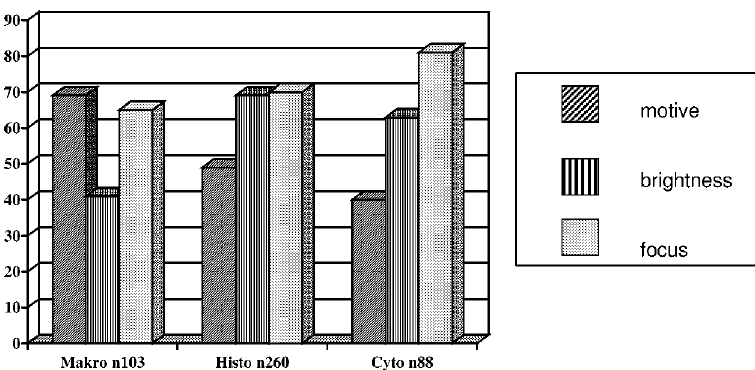
Fig. 4. Error analyses of 400 non-optimal images in percent of viewed images evaluating insufficient quality criteria motive, brightness and focus.